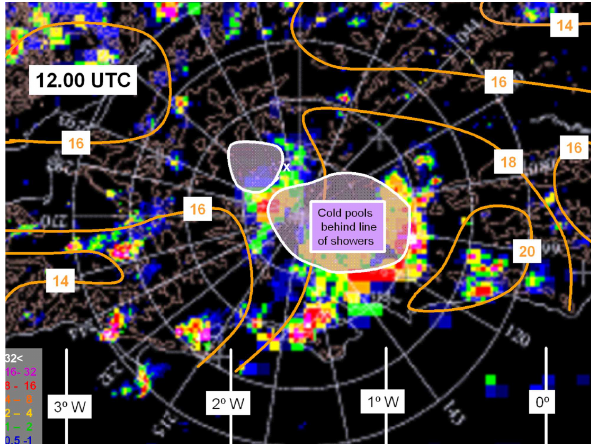
Fig. 10b. Microwave radiometer retrieval showing) temperature time-height cross sections for 0–2km height, 25 August 2005, 10:00–13:00UTC, plus time series of surface temperature, and in- tegrated water vapour. Purple lines indicate regions where the ra- diometer liquid water measurements showed liquid water reaching the surface, the green arrows indicate where IWV first started to fall quickly (indicative of where cooling plus incomplete saturation of dry air caused IWV to fall) and yellow arrow where the driest air was first detected.